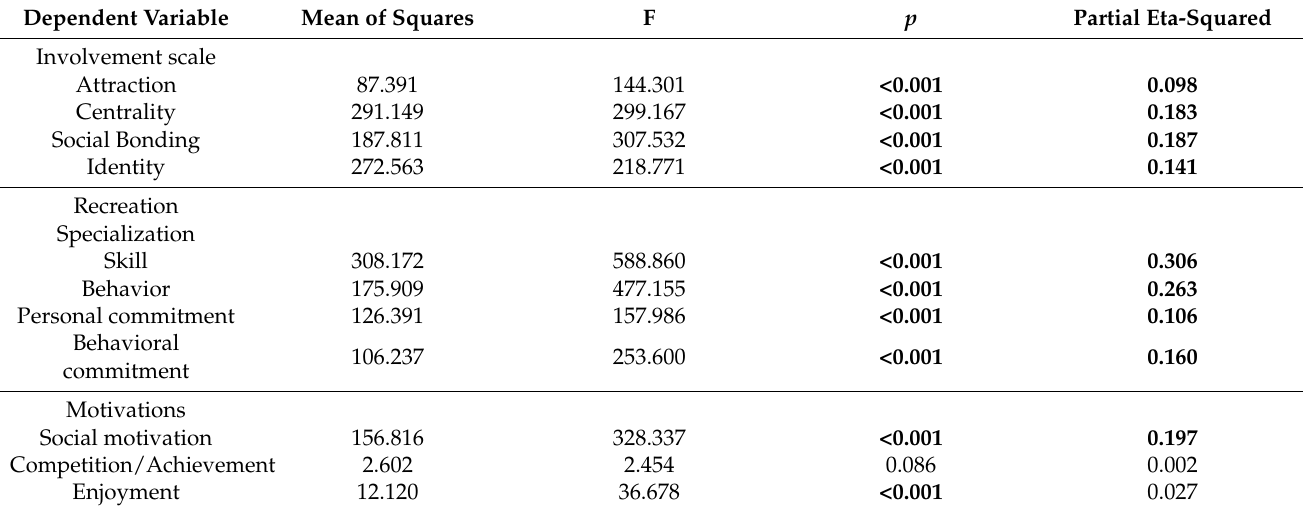
Table 2. Results of the multivariate model with the engagement cluster as the independent variable and birding specialization, involvement, and motivations as dependent variables.